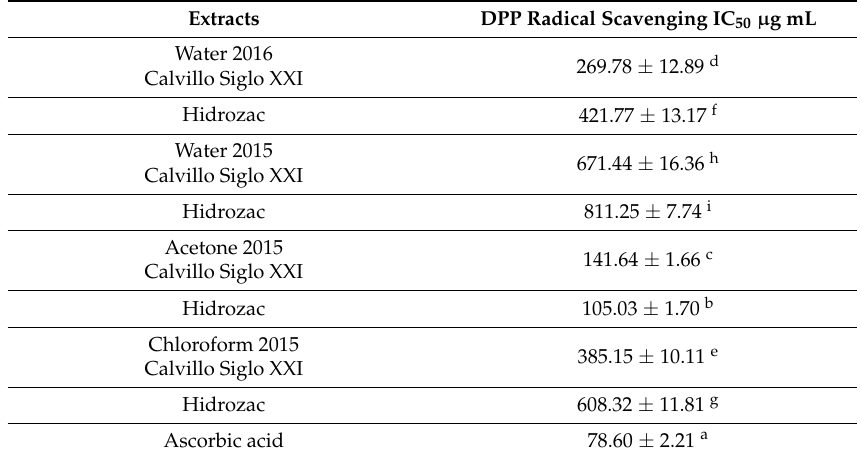
Table 5. DPPH radical scavenging ability in the aqueous, acetone, and chloroform extracts of the leaves of Calvillo Siglo XXI and Hidrozac. The average values ( ± SD) are expressed as half maximal inhibitory concentration in micrograms per milliliter (IC 50 µ